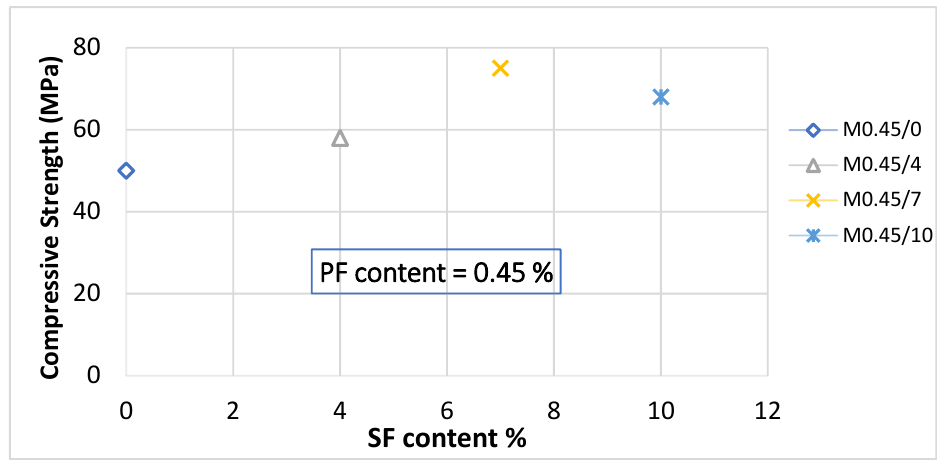
Figure 9. Effect of steel fiber content on compressive strength under ambient conditions.